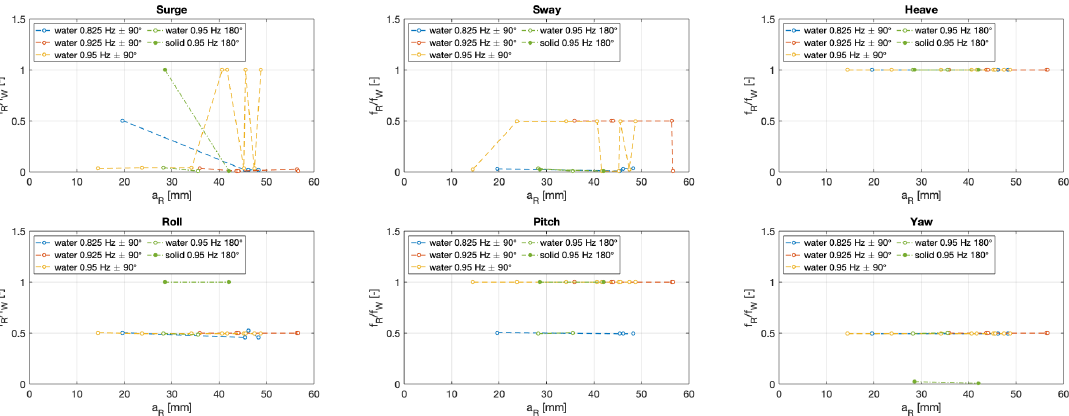
Figure 11. Frequency response f R normalised by the requested wave frequency f W and presented in relation to the measured wave amplitude a R in addition to Figure